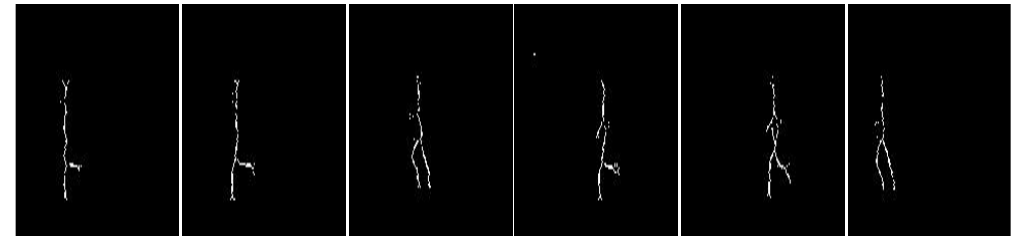
Figure 3. Sample sequence of skeleton images for a video of running